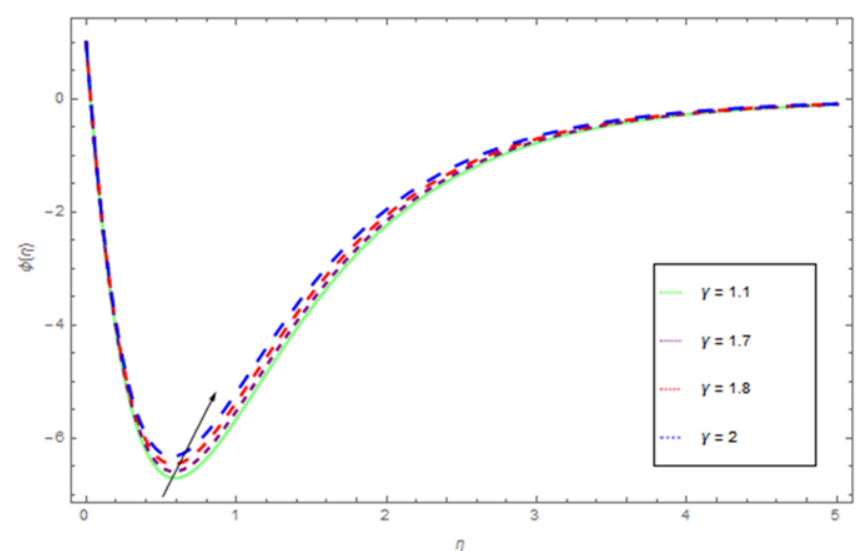
Figure 14. The influence of γ on φ ( η ) when Sc = 0.6, N t = 0.5, N b = 0.4.